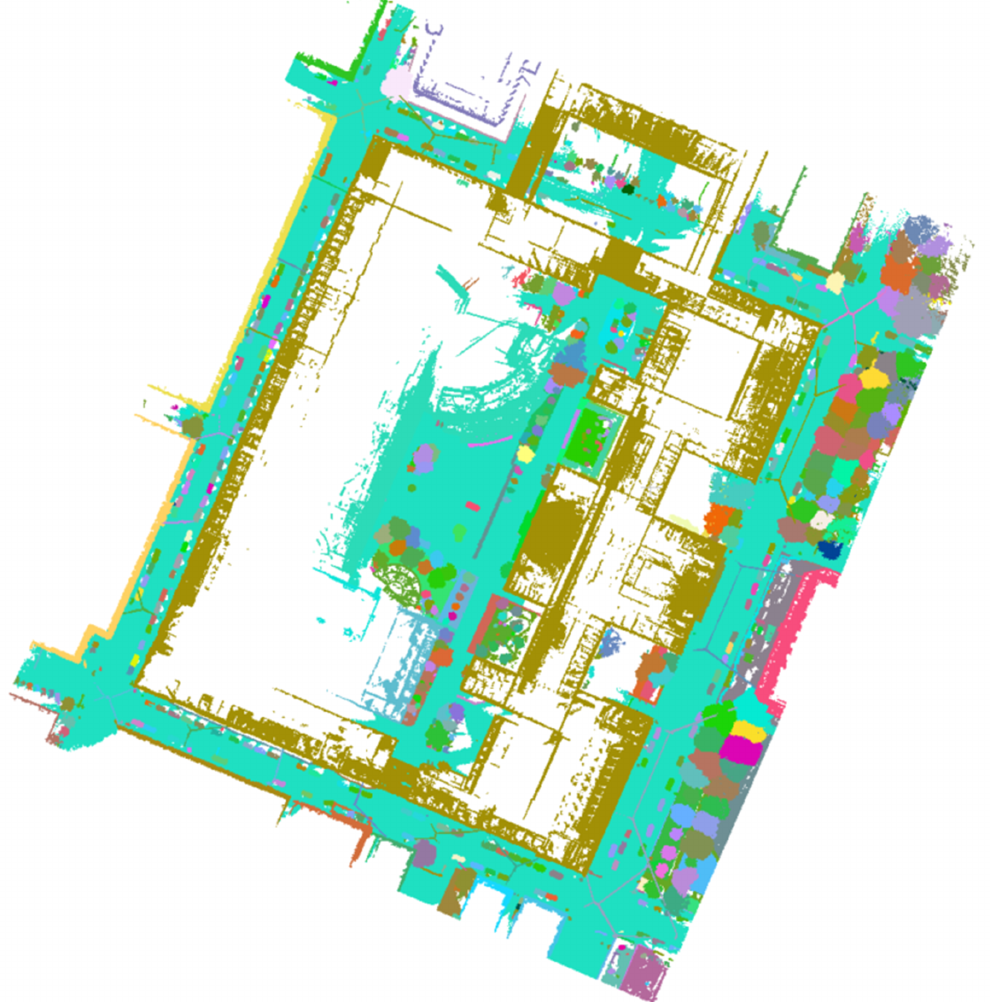
Figure 7. The instance segmentation of the labeled points. Points of the same objects are dyed into unique